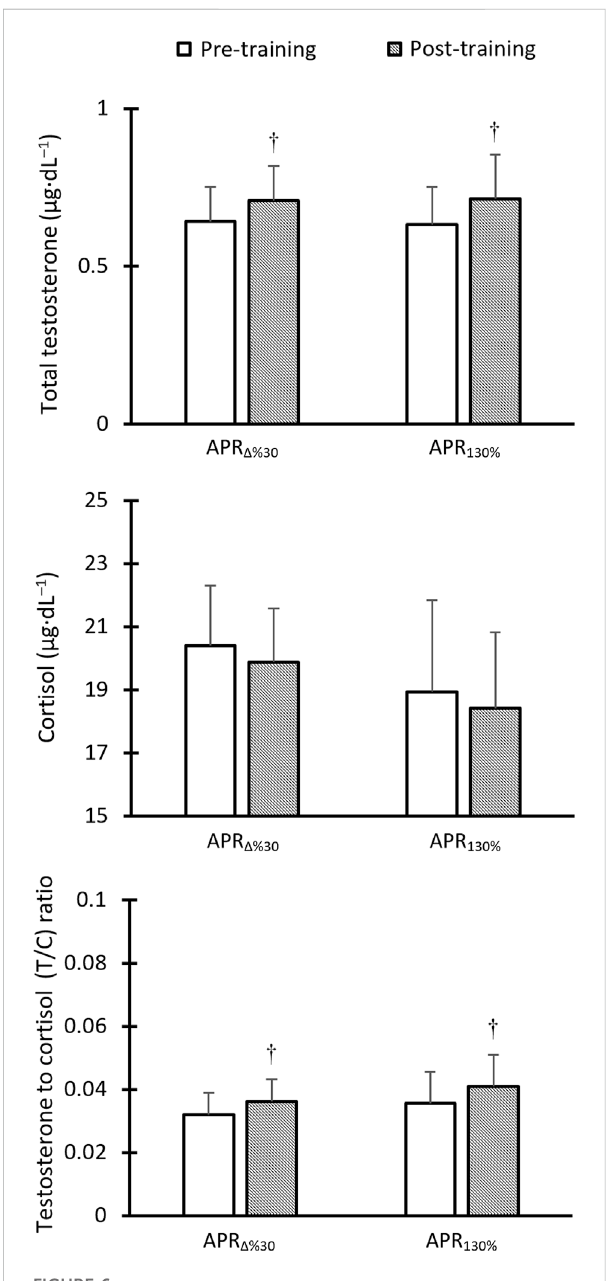
FIGURE 6 Hormonal changes in response to HIIT based on anaerobic power reserve (APR Δ %30 ) and maximal aerobic power (MAP 130% ) over time. † Denotes Signi fi cantly different versus pre-training (p ≤